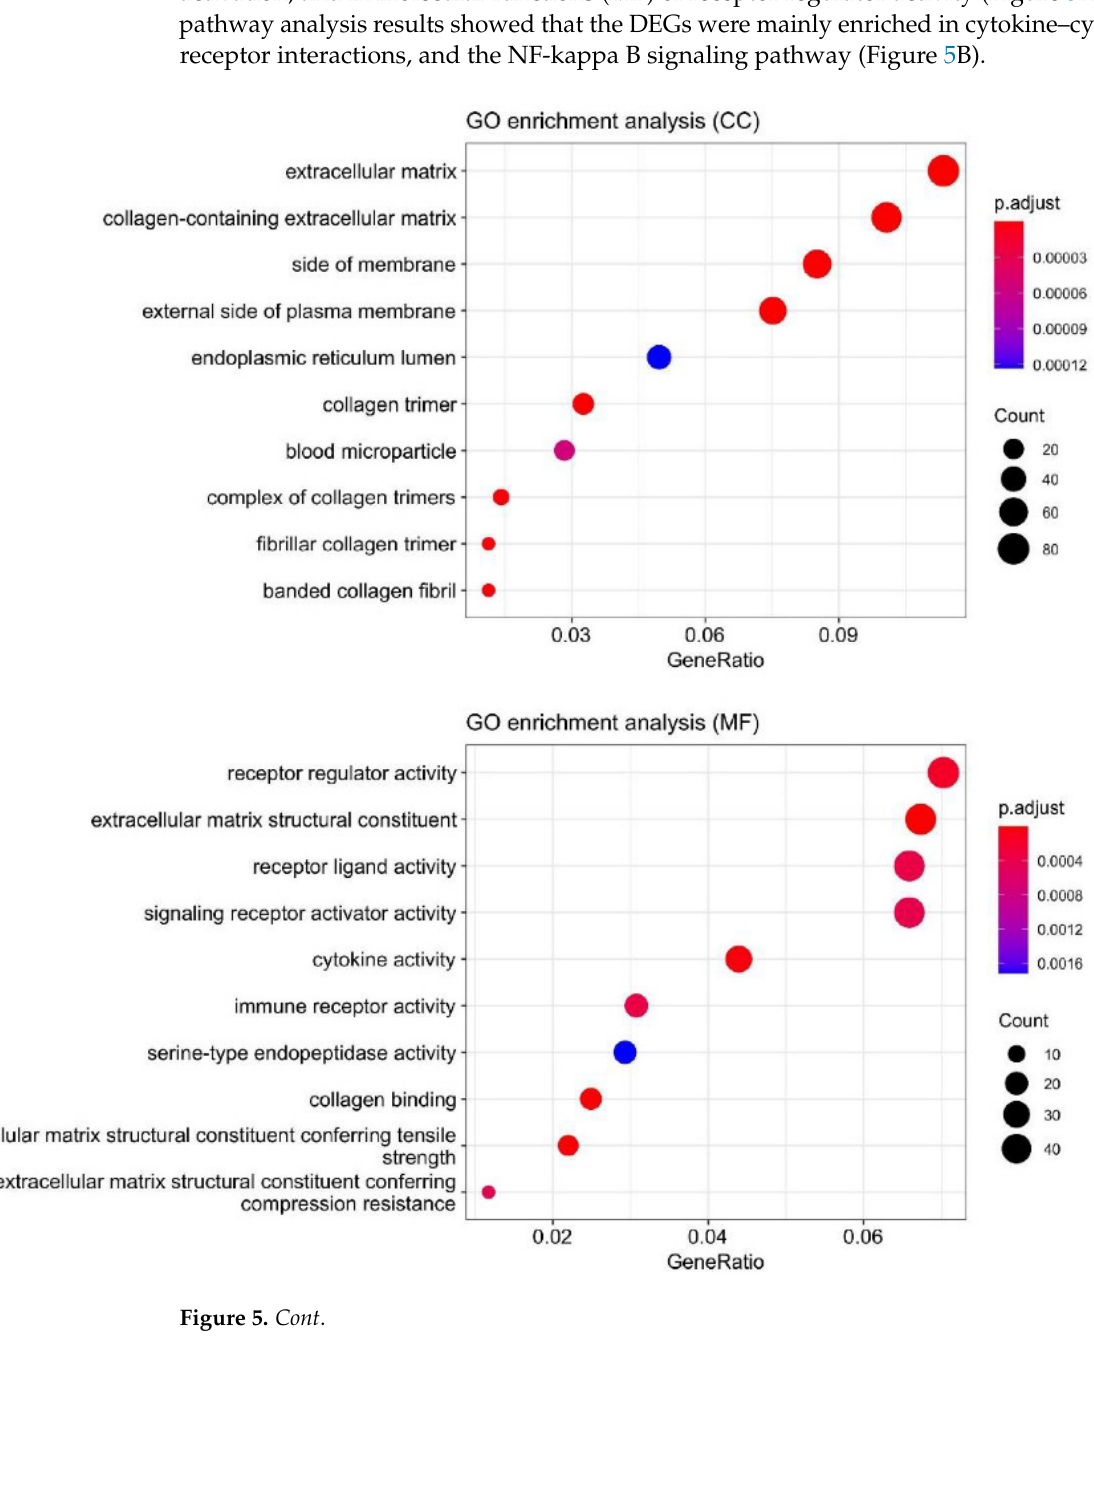
Figure 5. Functional and pathway enrichment analyses of DEGs between low and high SEMA7A KIRC subgroups (cut-off: 50%). ( A ) GO enrichment analysis in cellular components (CC), molecular functions (MF) and biological processes (BP). ( B ) KEGG enrichment analysis of DEGs.